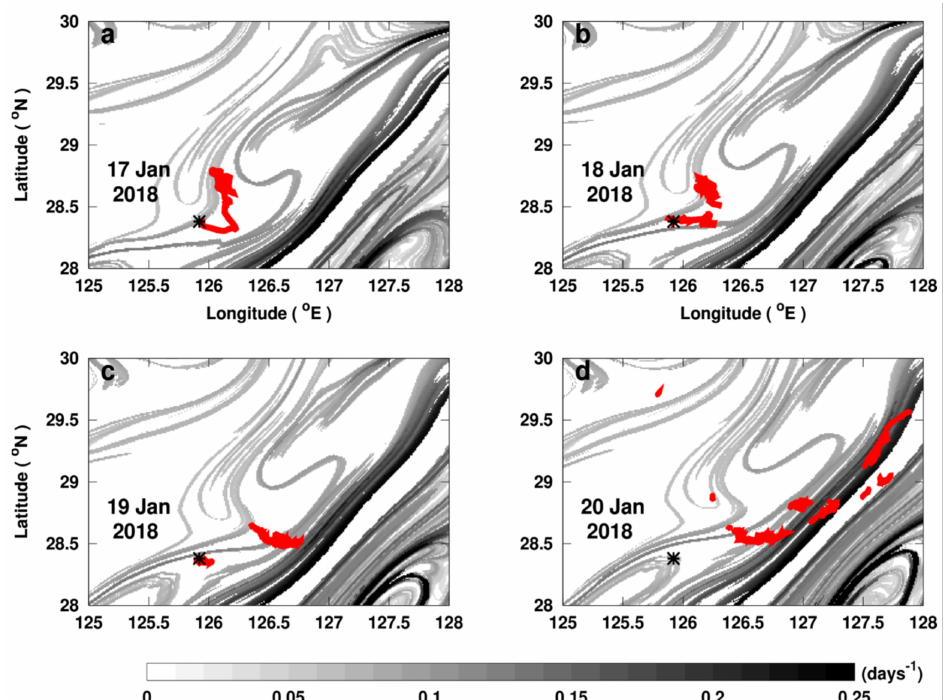
Figure A1. Daily backward finite-size Lyapunov exponent (FSLE) application repeated in the area of the East China Sea oil spill using the altimetry product in delayed-time. The black asterisk in all panels indicates the location where the Sanchi tanker sank. The red patch represents the daily evolution of the Sanchi leaked oil path from the 17th to 20th of January 2018 in panels ( a – d ), respectively. The gray-scaled filament-shaped fronts in the background represent daily Lagrangian fronts (FSLE computation using Altimetry Copernicus product in delayed-time). The altimetry- derived velocity product in delayed-time used here is available at E.U. Copernicus Marine Service Information (CMEMS). Daily surface observations of the global ocean are used in delayed-time (DT), with L4 processing level and a spatial resolution accounting for 0.25 ◦ × 0.25 ◦ (product